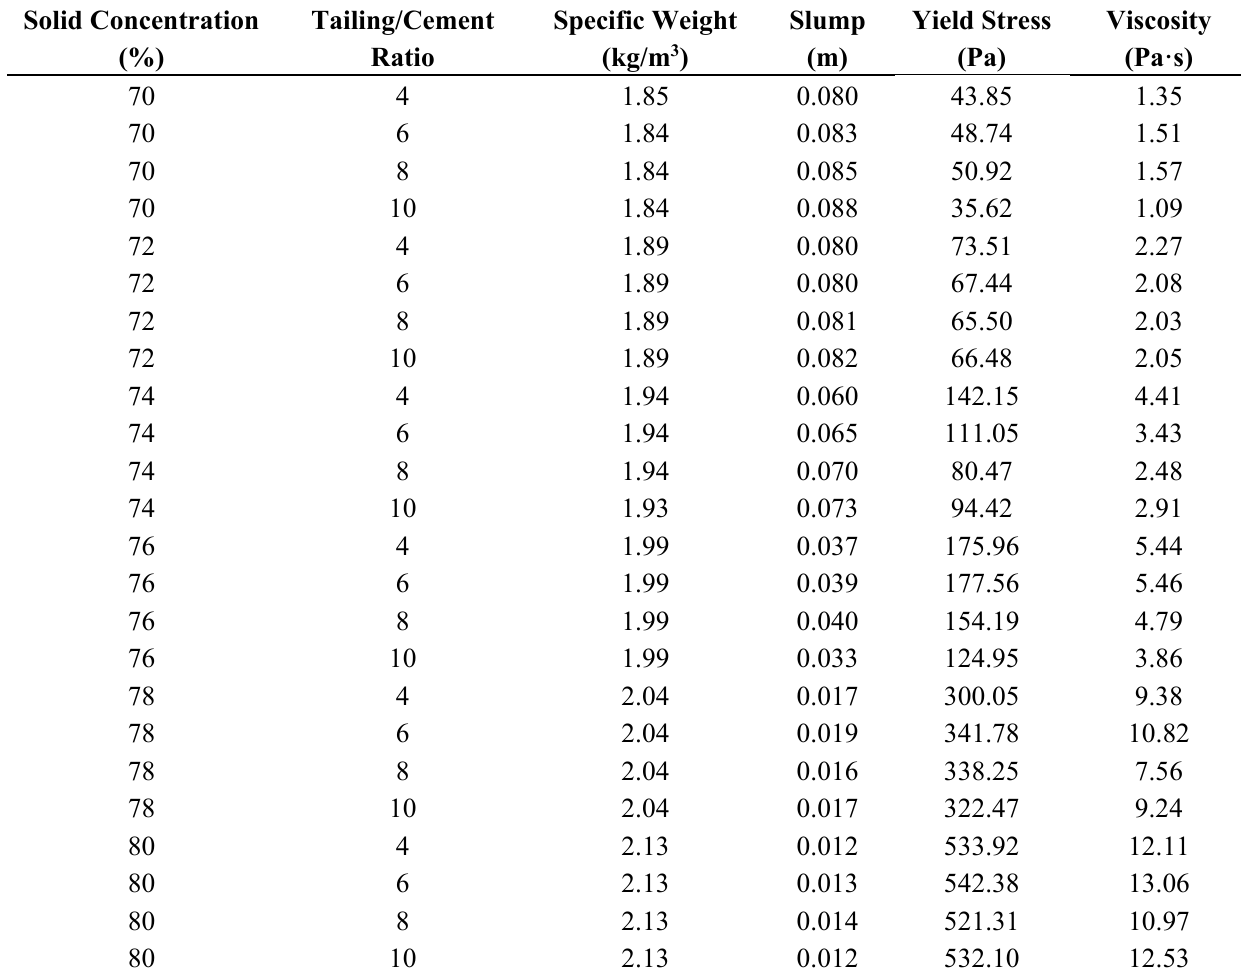
Table 5. Mix proportions and rheological parameters of cemented tailing